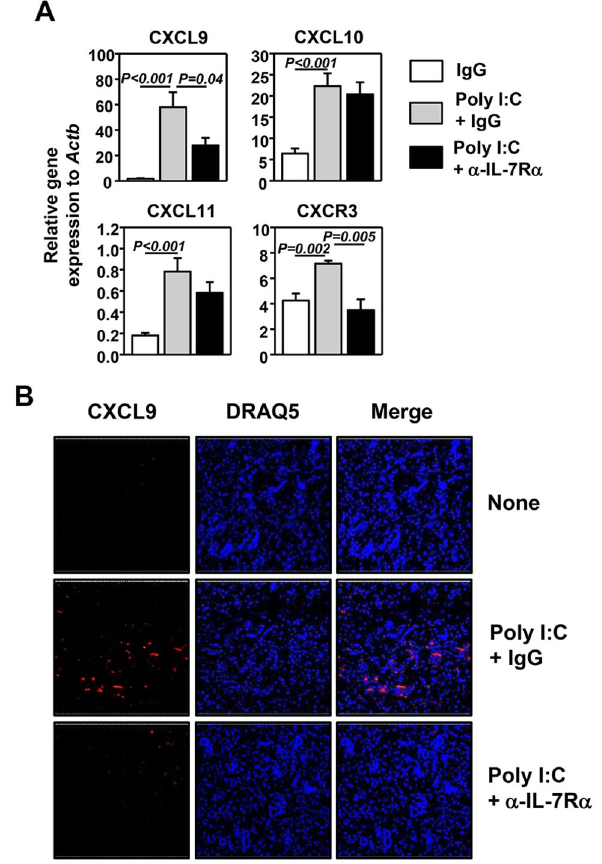
Figure 1. Poly I:C induces IL-7 expression in the submandibular glands. (A) Real-time PCR analysis of gene expression in submandibular glands from C57BL/6 mice 6 hours post poly I:C injection, presented relative to that of β- actin. Data are the average of analyses of 6 individual mice (3 mice per experiment, total 2 independent experiments). (B) Immunofluorescence staining of IL-7 in submandibular gland sections from C57BL/6 mice 24 hourse post poly I:C injection. Differential interference contrast (DIC) image of the same sample is also shown. Data are representative of analyses of 6 individual mice (3 mice per experiment, total 2 independent experiments). (C) C57BL/6 mice were pretreated with anti- IFNAR1 or anti-IFN-γ 2 hours prior to poly I:C injection. After 6 hours, relative IL-7 mRNA levels in lung tissue were measured by real-time RT-PCR. Data are from analyses of 6 individual mice (2 mice per experiment, total 3 independent experiments). IFN-γ in the submandibular glands 6 hours later. Poly I:C induced up-regulation of both IFN-γ and CXCR3 ligands in RAG1 -/- mice in the absence of lymphocytes, but it could not do so when NK cells were depleted from these mice by treatment with an anti-NK1.1 antibody (Figure 3B). Hence, at early phase after poly I:C stimulation, the induction of IFN-γ and CXCR3